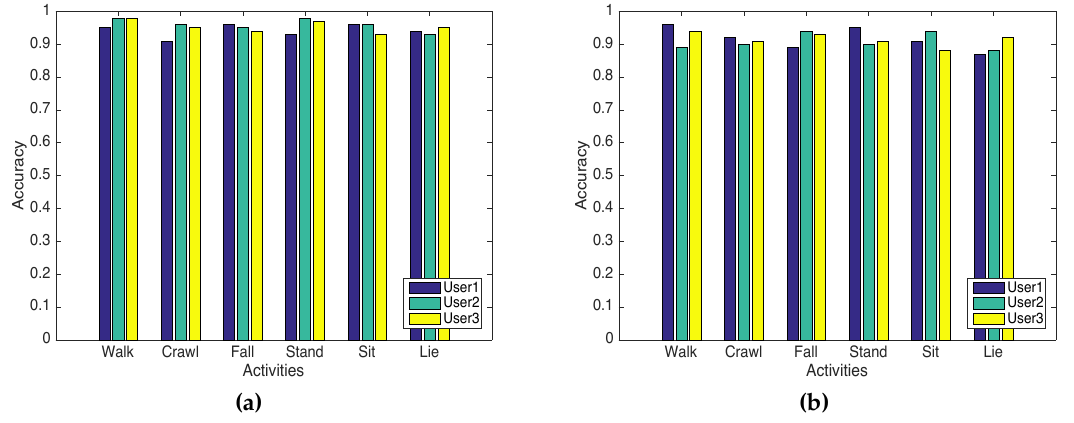
Figure 8. Classification accuracy results with less training samples. ( a ) the results in LOS scenario; and ( b ) the results in NLOS scenario.